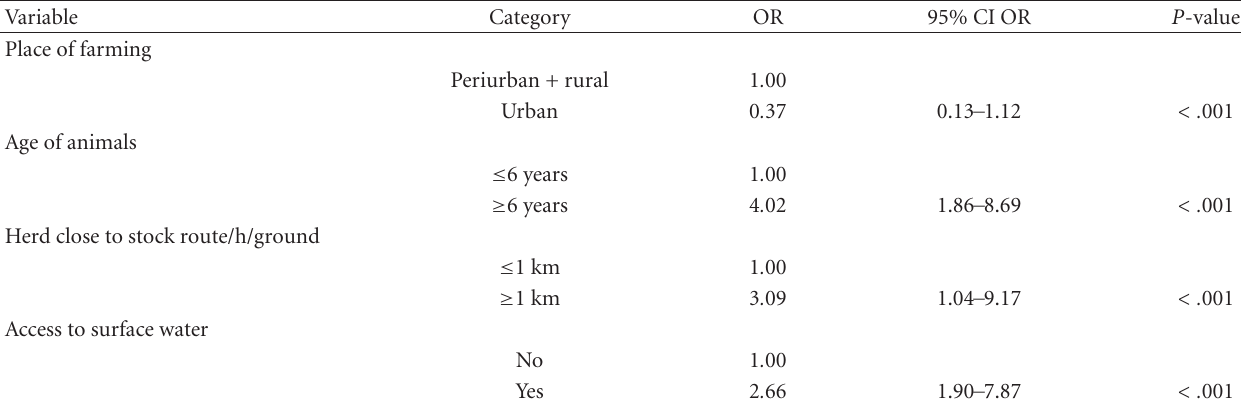
Table 4: Significant factors associated with seropositivity to Brucella infection in multivariable logistic models (May 2003 − January 2004).